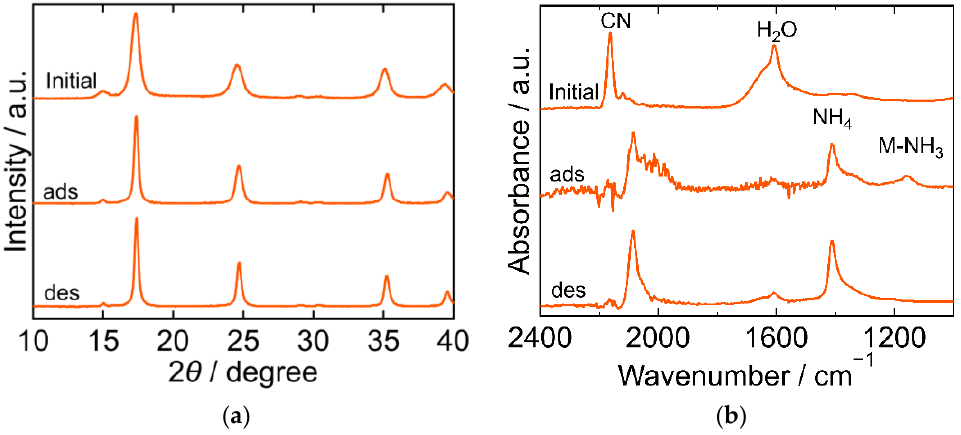
Figure 4. XRD patterns ( a ) and FTIR spectra ( b ) of Nickel hexacyanoferrate. “Initial” sample is literally the sample before adsorption. The samples after adsorption and desorption are denoted by “ads” and “des”, respectively. The measurements were performed at ambient temperature.